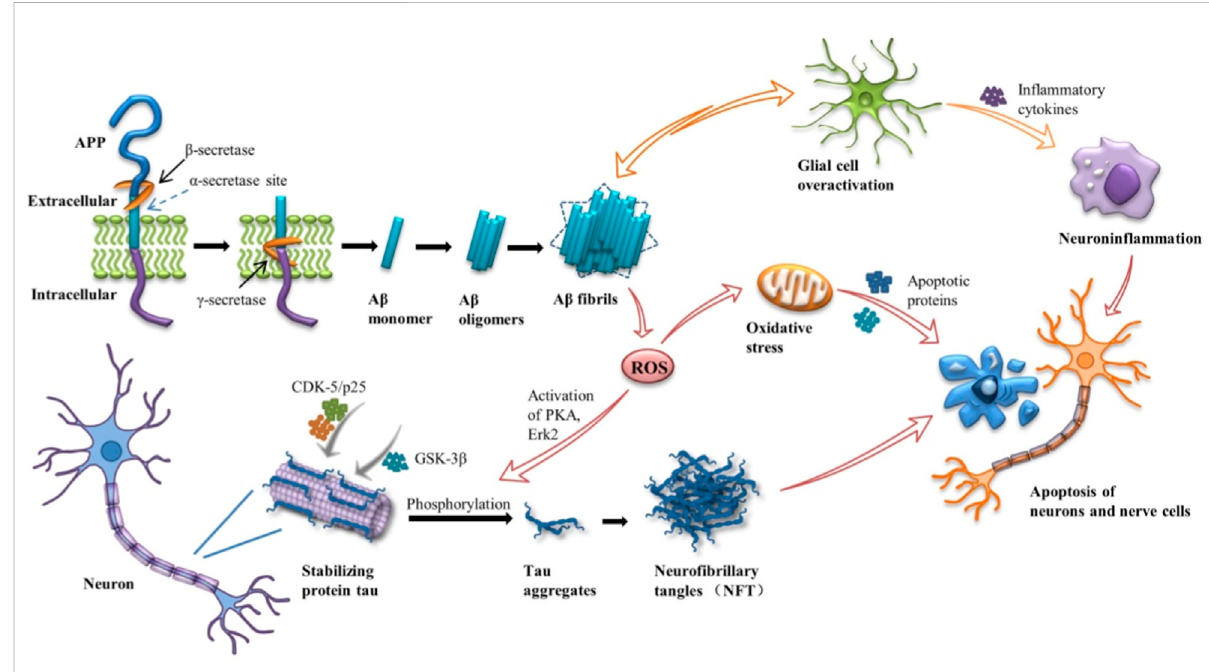
FIGURE 1 Amyloid cascade in Alzheimer ’ s disease (AD). APP, amyloid - β protein precursors; CDK-5, cyclin-dependent kinase-5; GSK3- β , glycogen synthase kinase 3- β ; PKA, protein kinase A; Erk2, extracellular signal-regulated kinase